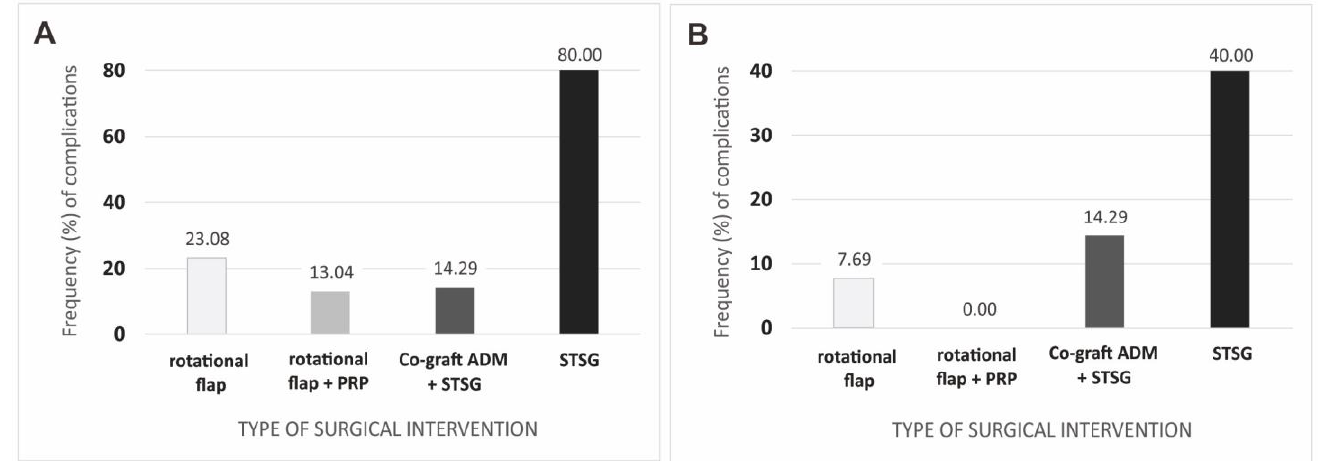
10 of 15 Figure 5. Duration of hospitalization depends on the type of surgical intervention. Legend: PRP, platelet-rich plasma; ADM, acellular dermal matrix; STSG, split-thickness skin graft. It was also examined whether the type of surgical intervention affected the rate of postoperative complications. At two-week follow-up, the highest complication rate was